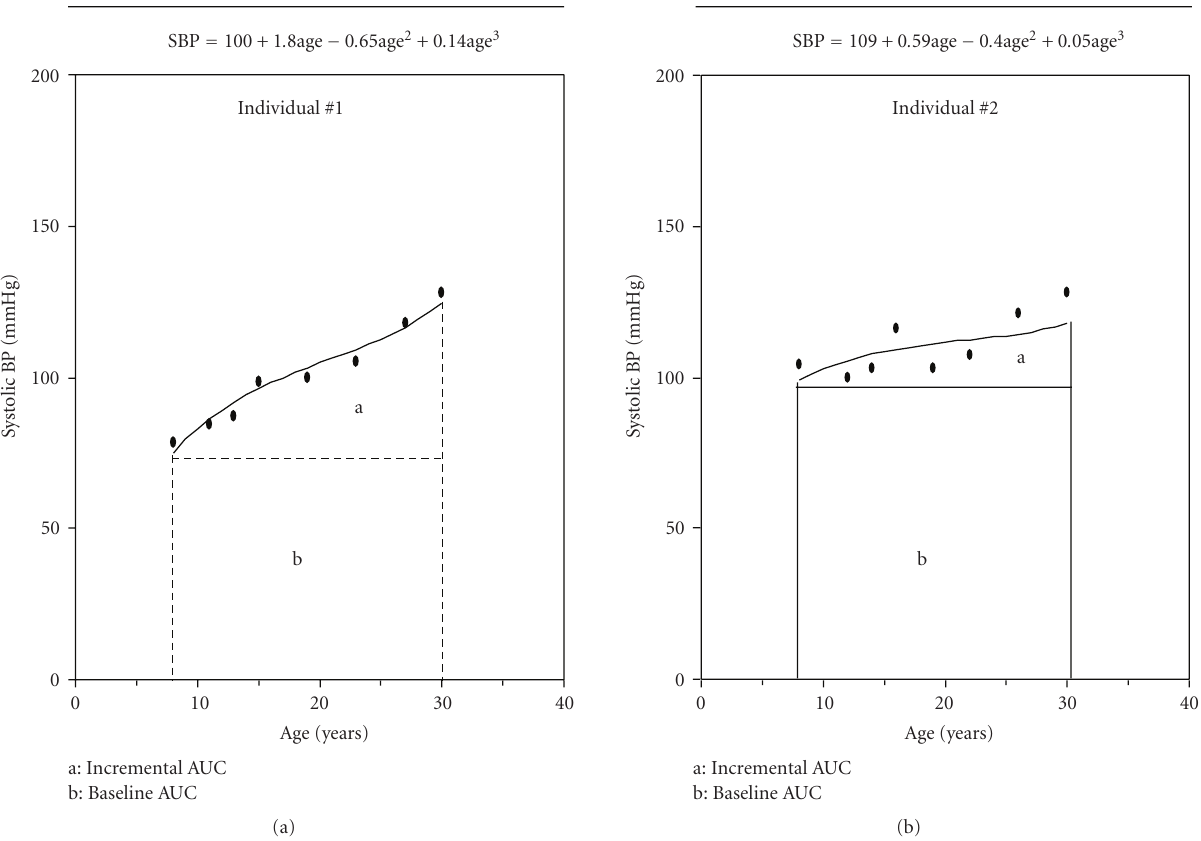
Figure 1: Illustration for Calculation of Area under the Curve of Systolic Blood Pressure: The Bogalusa Heart Study.